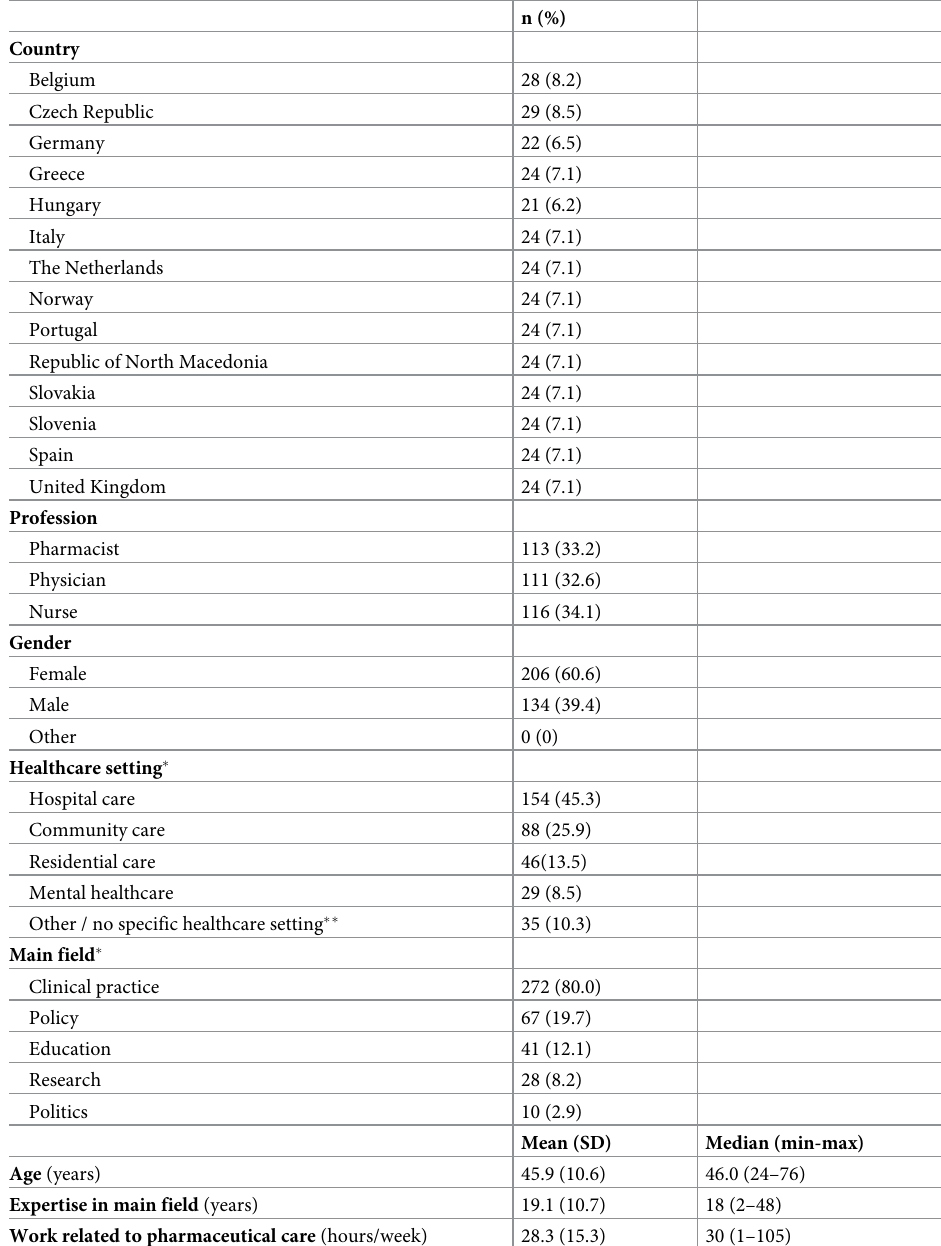
Table 1. Population